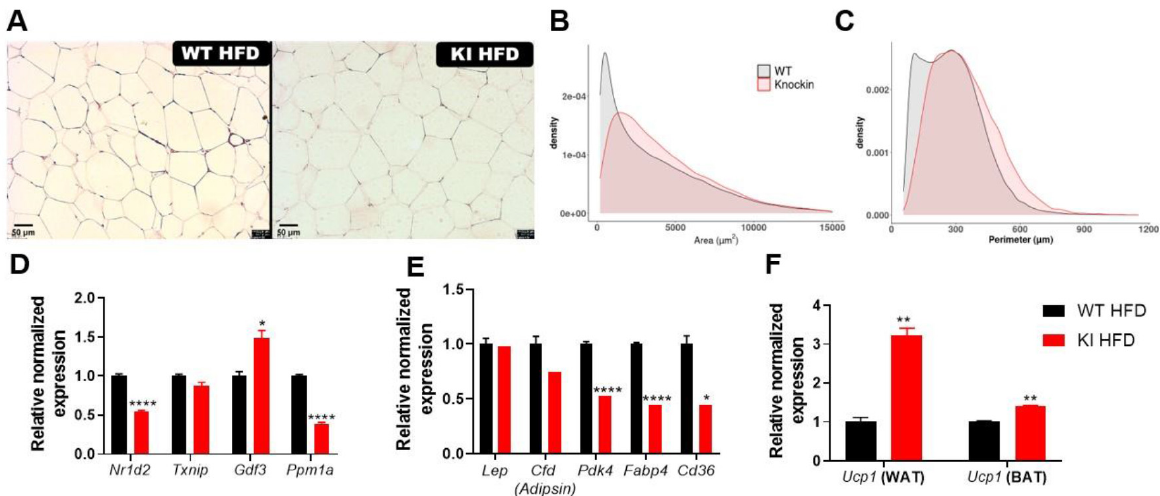
Figure 5. White adipose tissue (WAT) analysis after 18 weeks of high-fat diet feeding. ( A ) WAT histology after embedding it in paraffin and slides were prepared with 5 µm cuts. Analysis of WAT considering density of adipocytes on each ( B ) area and ( C ) perimeter, divided into each group. Relative normalized expression of ( D ) genes regulated by S273 phosphorylation in WAT: Nr1d2 and Txnip described by Choi in 2010, Gdf3 and Ppm1a described in 2020. ( E ) Genes involved on PPAR γ and lipid metabolism pathways in WAT: leptin ( Lep ), adipsin ( Cfd ), Pdk4 (pyruvate kinase dehydrogenase), Fabp4 (fatty acid binding protein 4), and Cd36 (scavenger receptor). ( F ) Ucp1 expression in WAT and BAT. Data were normalized to the expression of reference genes: 36b4 and Rpl27 . Data are represented as mean ± SEM. Statistical analysis was performed using Dunnett’s T3 multiple comparison ANOVA test. * p < 0.05, ** p < 0.01 and **** p < 0.0001. n ≥ 5 per group.